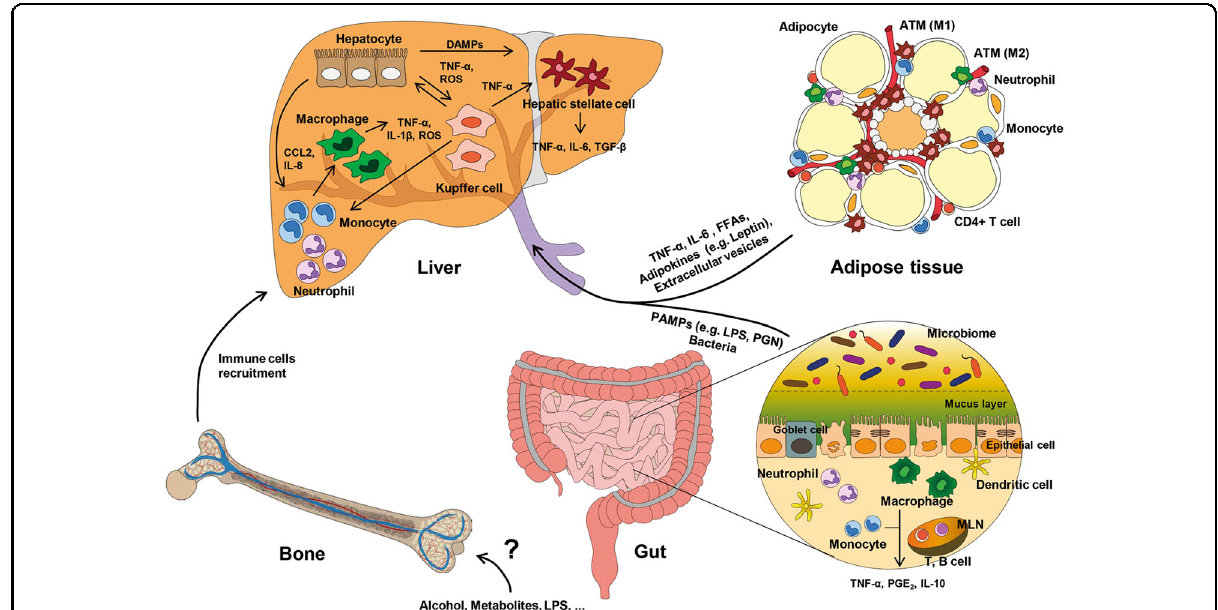
Fig. 1 Inter-organ cross-talk in alcoholic liver disease. Alcohol consumption induces lipolysis in adipocytes and in fl ammatory responses in adipose immune cells, including macrophages, which in turn lead to the release of free fatty acids (FFAs), adipokines (e.g., leptin), and cytokines (e.g., TNF- α and IL-6) into the portal circulation. In addition, alcohol intake alters the gut microbiome composition and increases the permeability of intestinal bacteria and their metabolites through broken barriers of epithelial cells in the gut, thus leading to translocation of bacteria and in fl ammatory cells in the liver. Therefore, metabolic and immunogenic factors, including DAMPs and PAMPs, from adipose tissue and the gut enter the liver, affecting hepatocytes and non-parenchymal cells in the liver to recruit pro-in fl ammatory immune cells from the bone marrow. Taken together, inter-organ cross-talk between the liver and other organs plays a critical role in the pathogenesis of